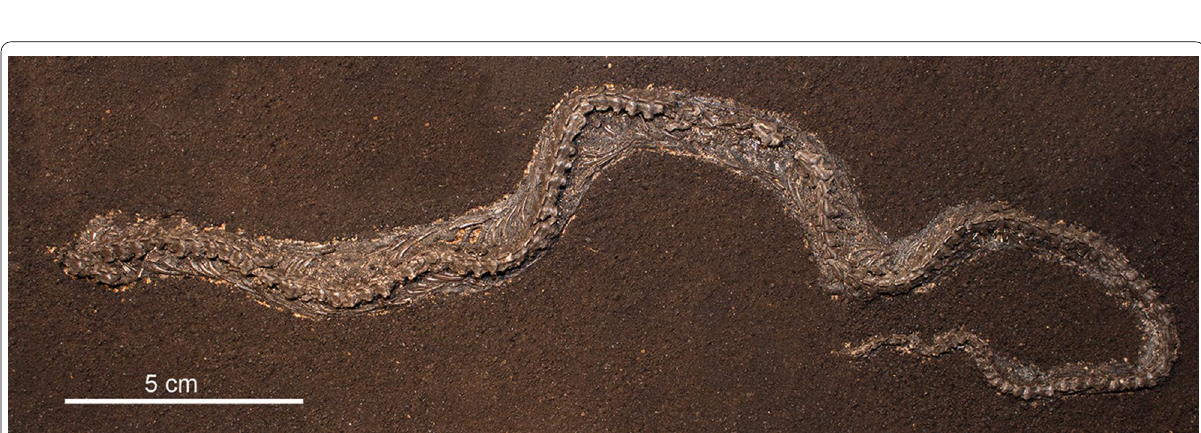
Fig. 21 Palaeopython ceciliensis from quarry XXII, Geiseltal: small portion of a skeleton on matrix (GMH